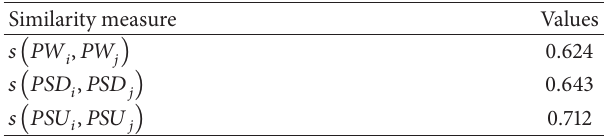
Table 2: Average similarity measure between